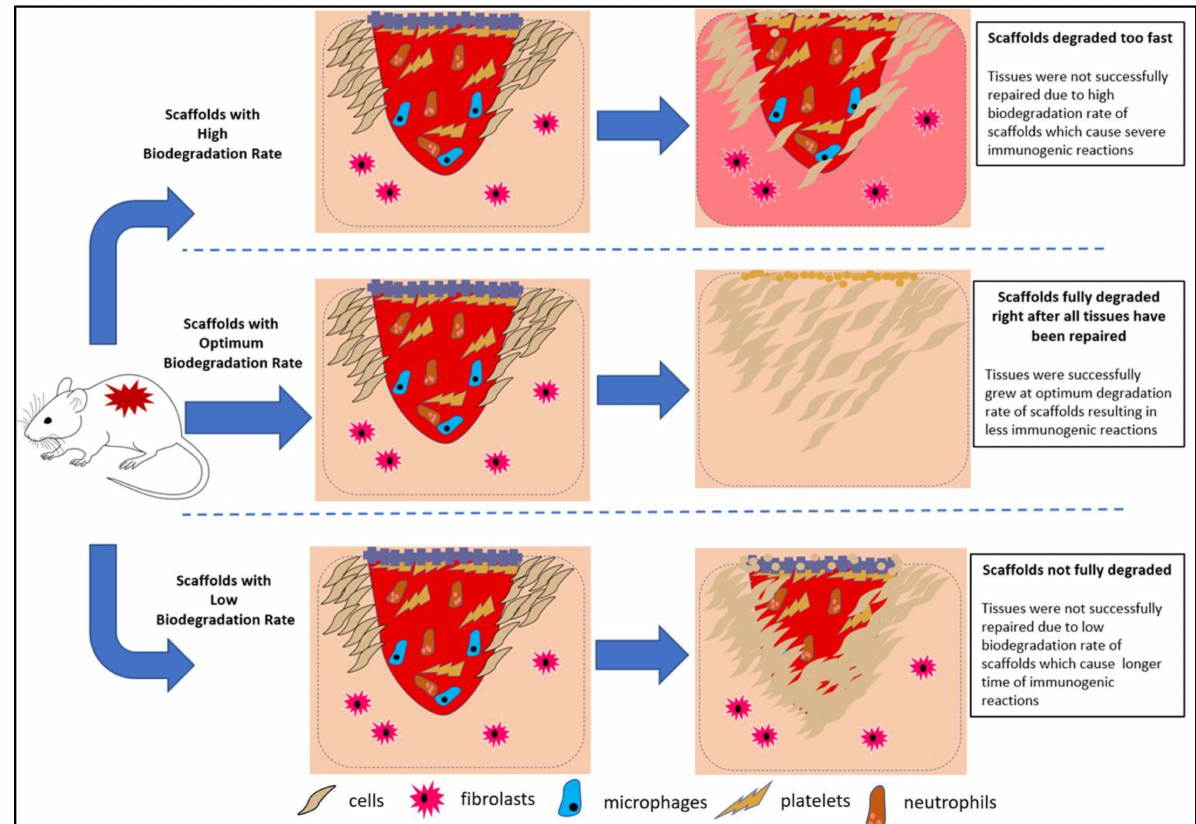
Figure 12. Illustration of the different immunogenic responses towards the specific biodegradation trends of